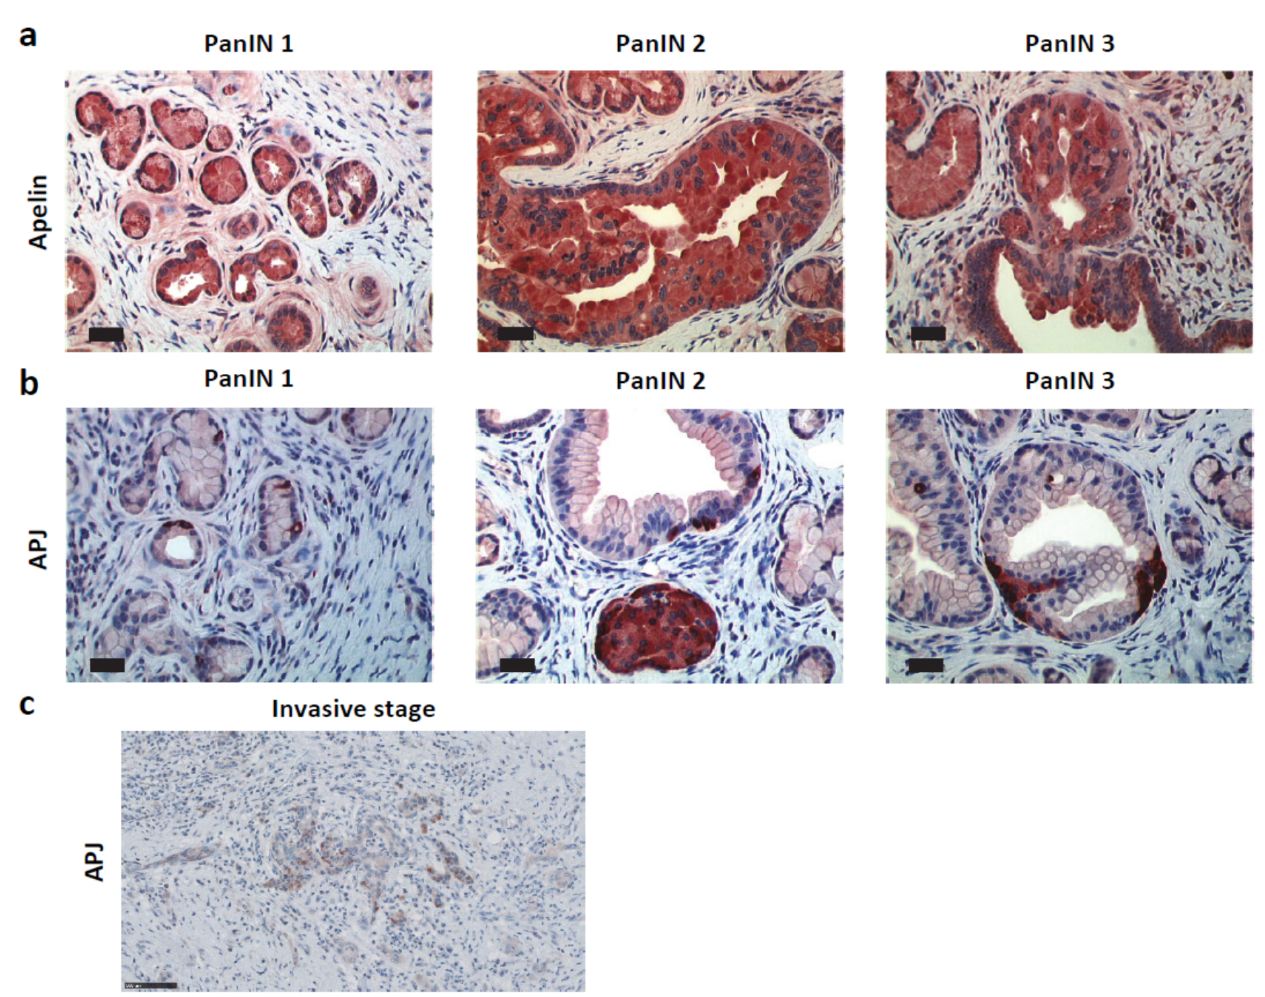
Figure 3. Apelin and APJ are expressed early during pancreatic carcinogenesis. Immunohistochem- istry analysis of apelin ( a ) and apelin receptor ( b ) expression from PanIN 1 to PanIN 3 in KC mouse model ( n = 7). Note the difference in expression pattern between apelin, the expressed by cells comprising PanIN and the APJ expressed by isolated cells surrounding PanIN structures. Scale bar, 34 µ m. ( c ) Apelin receptor staining in KC mouse model in invasive stage. Representative image from n = 7. Scale bar, 100 µ